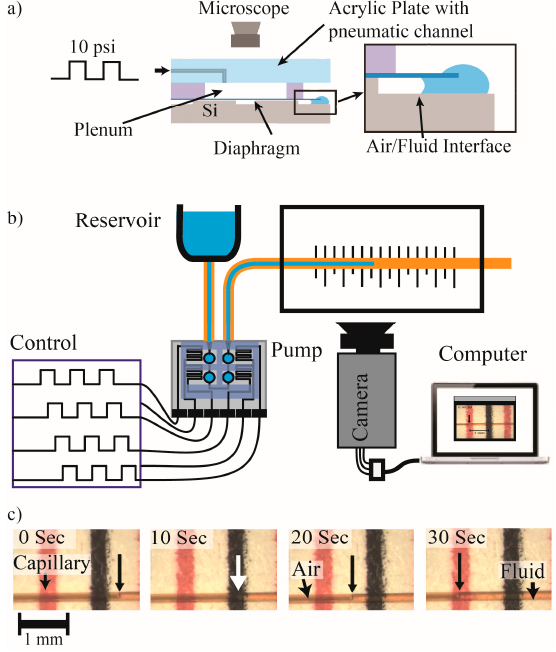
Figure 5. ( a ) Illustration of the long-term diaphragm deflection test set-up. Magnification shows a close up of the air/water interface examined on a weekly basis; ( b ) Set-up for gallium thermal actuation peristaltic pump characterization; ( c ) Photographic sequence of the output capillary over printed gradations for fluid movement measurement demonstrates 1.5 mm movement (14.8 nL) over 30 s for a pump rate of 29.6